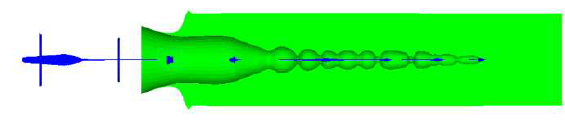
Fig. 8. penetration feature according to the JC model at